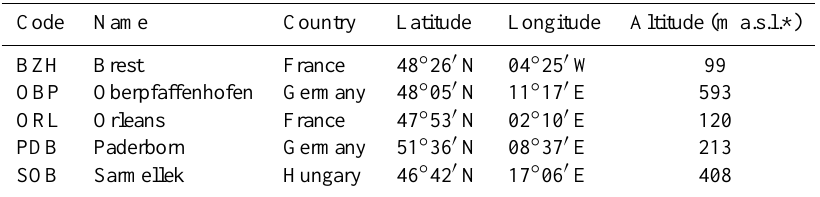
Table 1. Airport acronyms and geographical information.